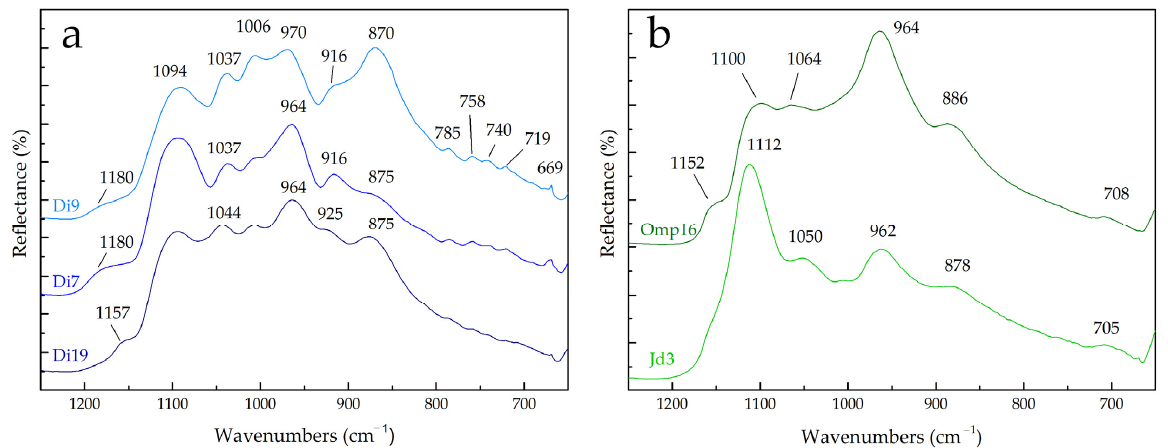
Figure 12. FTIR spectra of area 9, 7, and 19 corresponding to diopside (Di) points ( a ), and FTIR spectra of area 16, 3 corre- sponding to omphacite (Omp) and Na-rich omphacite (Jd) points ( b ). The FTIR reflectance spectra of diopside (Figure 12a) show broad bands at 1094, 1006, and 970–964 cm − 1 attributed to the characteristic Si-O stretching modes of the SiO 4 tetrahedron, while the sharp peak at 669 cm − 1 and the other peak at 875–870 cm − 1 are assigned to the non-bridging bending vibration of O-Si-O and non-bridging stretching mode of Si-O, respectively [39–41]. All the detected bands are in good agreement with